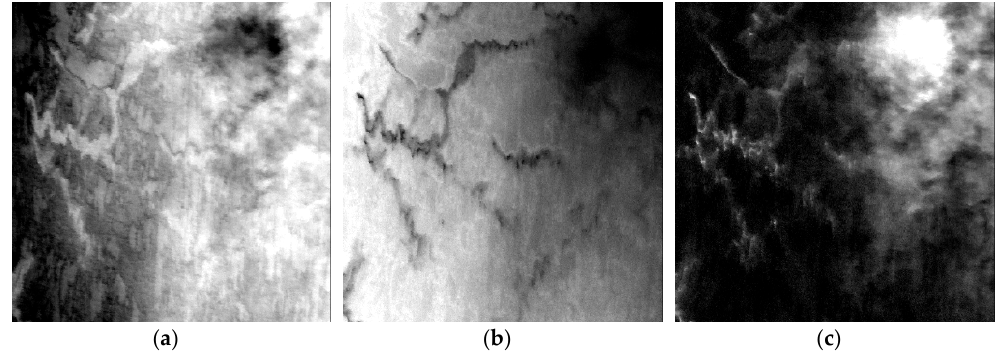
Figure 18. The abundance maps using DSPP+MVSA. ( a ) oil; ( b ) water; ( c ) cloud.